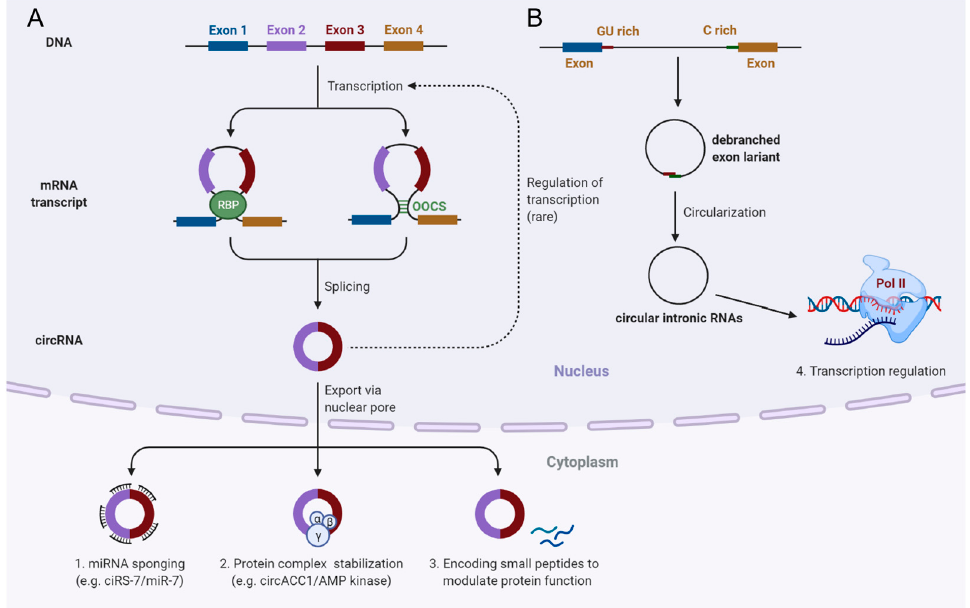
Figure 3. Main biogenesis pathways and functions of circRNAs in cells. ( A ), Biogenesis of exonic circRNA from back-splicing of pre-mRNA. RNA-binding proteins (RBPs) or orientation-opposite complementary sequences (OOCS) that form loop-like structures facilitate back-splicing and circRNAs formation; these circRNAs are generally exported to the cytoplasm and act as a miRNA sponge, protein complex coordinators as well as small peptide producers to modulate protein function; ( B ), Biogenesis of lncRNAs from intron lariats. A consensus RNA motif containing a 7-nt GU-rich element near the 5 ′ splice site and an 11-nt C-rich element near the branch point prevents detaching of the intron lariats and promotes intronic circRNA formation; these circRNAs are retained in the nucleus and mainly regulate Pol II-mediated transcription. The figure is created with Biorender (Biorender.com (accessed on 28 January 2022)).